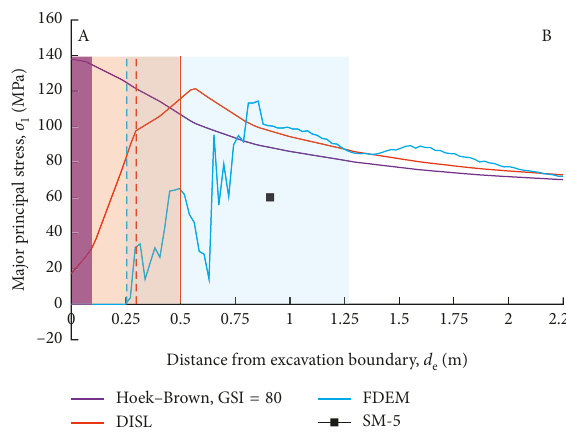
Figure 11: Major principal stresses σ 1 monitored along the line (AB) (Figure 12) for the intact FEM Hoek–Brown model (purple line), the intact FEM-DISL model (red line), and the intact FDEM model (blue line). In situ stress measurements (stress cell SM-5) are plotted for comparison [50]. The purple hatched area indicates the extent of the damaged zone (yielded elements) for the FEM Hoek–Brown model along line (AB). The red hatched area indicates the extent of the damaged zone (yielded elements) for the FEM- DISL model along line (AB). The blue hatched area indicates the extent of the damaged zone (failure of cohesive elements) for the FDEM model along line (AB). The blue dashed line indicates the ending point of the collapsed material and the starting point of the damaged zone in the FDEM model. The red dashed line in- dicates the ending point of the HDZ and the starting point of the EDZ in the FEM-DISL model. The red continuous line indicates the ending point of the EDZ in the FEM-DISL